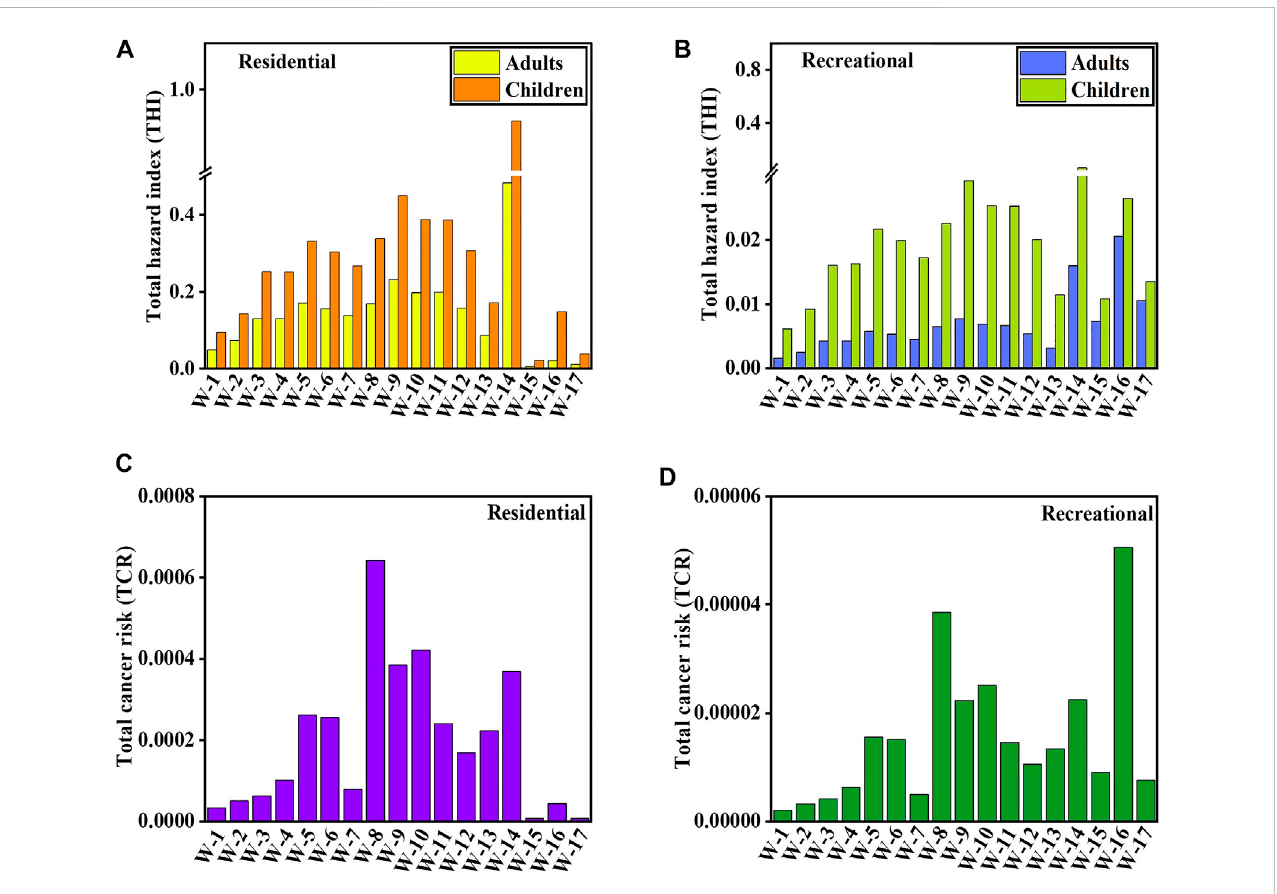
Total hazard index (THI) and total carcinogenic risk (TCR) for residential (A,C) and recreational (B,D) receptors from heavy metals in surface